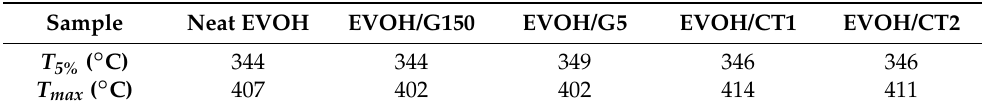
Table 1. Comparison of T 5% and T max values as a function of the studied EVOH/Graphene nanocom- posite (the uncertainty is better than 1 ◦